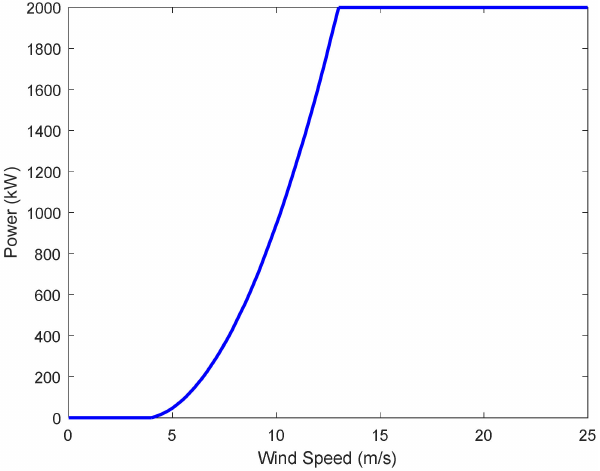
Figure 3. The power